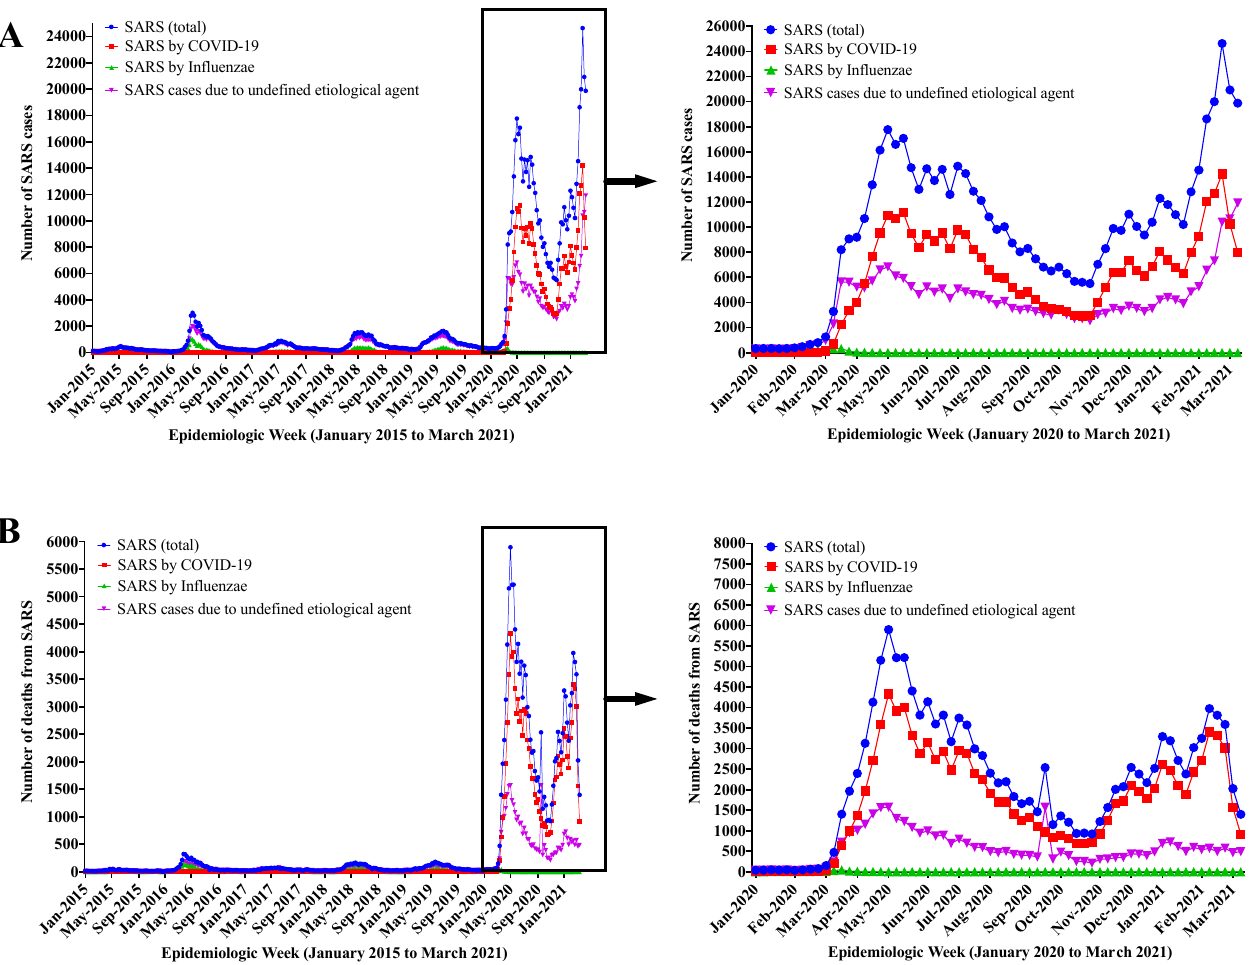
Figure 3. Number of cases ( A ) and deaths ( B ) from severe acute respiratory syndrome (SARS) due to the Coronavirus Disease (COVID-19) pandemic development, according to the etiological agent, in the period from January 2015 to March 2021.